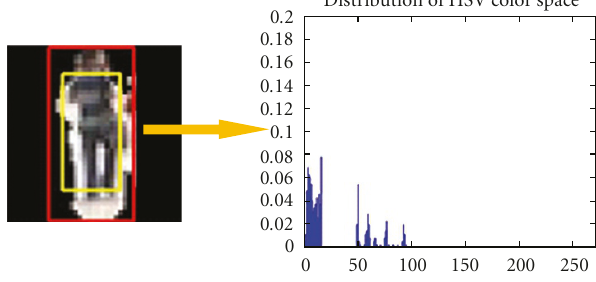
Figure 13: The PDF of color